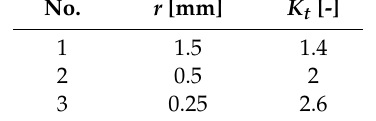
Figure 1. Geometry of the specimen for fatigue testing ( a ) Smooth; ( b ) Notched. Table 2. Dimensions of the notched Table 1. Chemical composition of austenitic steel 1.4301 (X5CrNi18-10) according to [21] and measured value.